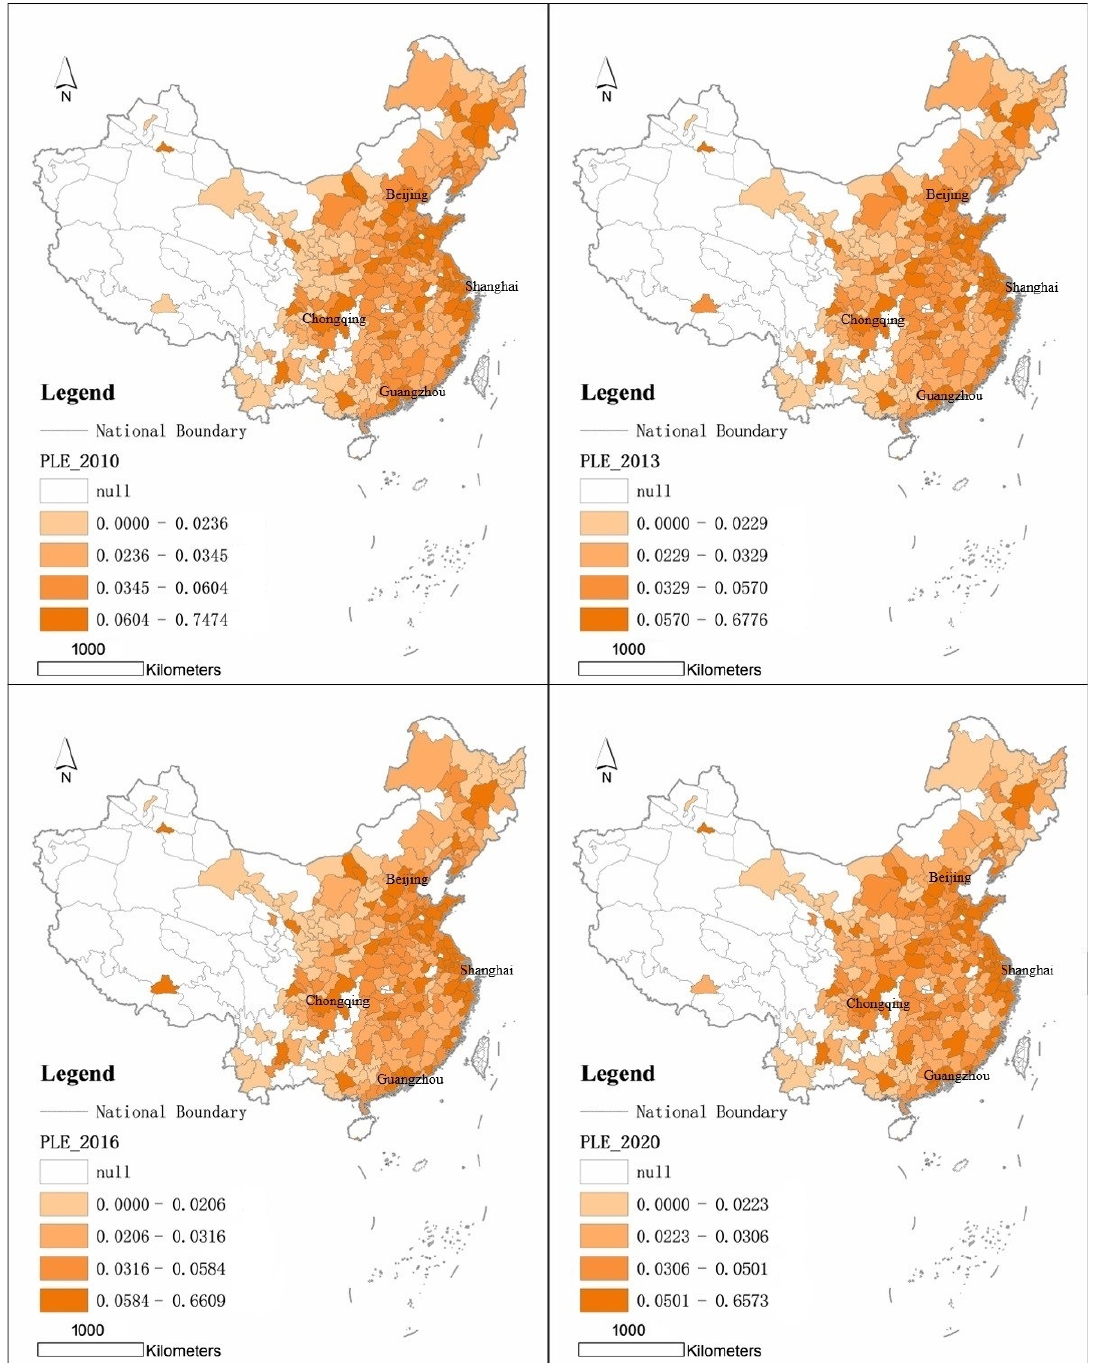
Figure 3. Spatial and temporal patterns of “production, living and ecological” environmental qual- ity scores in cities, 2010–2020. scores in cities,